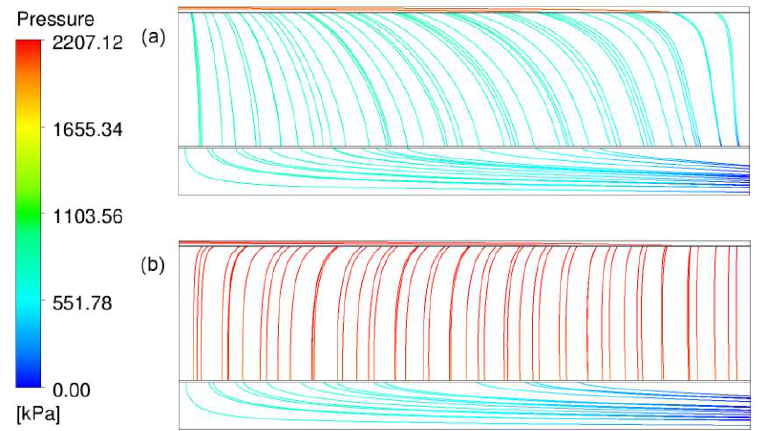
Figure 11. Pressure profile and streamline in PBRs of increased resistance of cold frit or hot frit. ( a ) Cold frit-dominated PBR; ( b ) hot frit-dominated PBR.